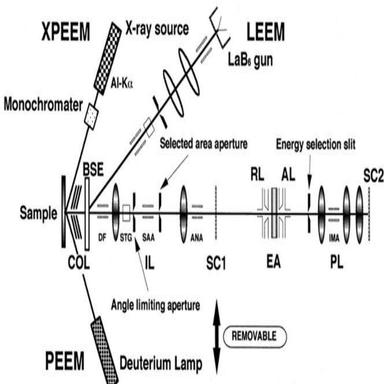
(a) Diagram of XPEEM system. COL: cathode objective lens, BSE: beam separator, IL: intermediate lens, SC1: screen 1, RL: retardation lens, EA: Wien filter, AL: acceleration lens, PL: project lens, SC2: screen 2.